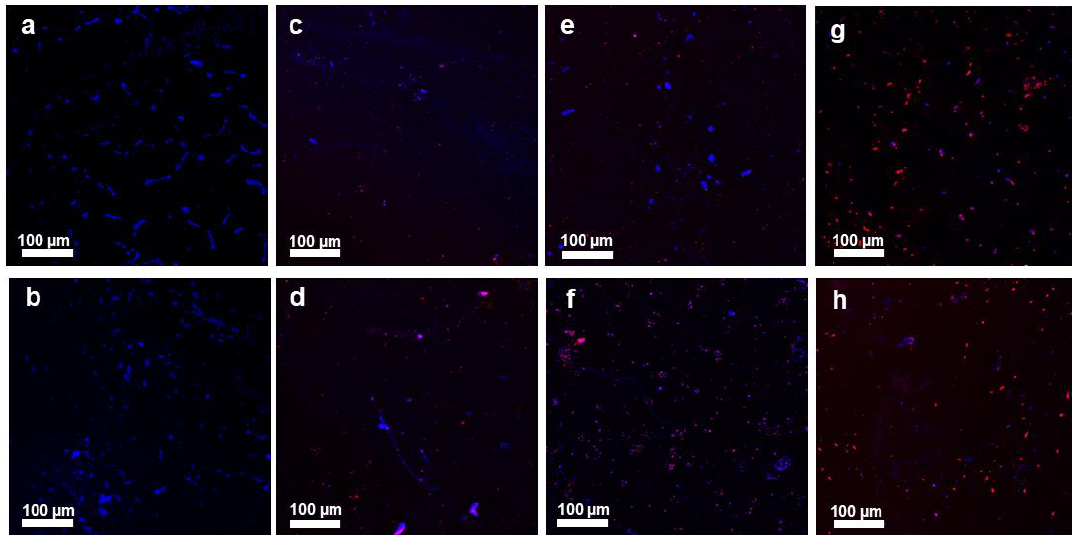
Figure 8. Confocal fluorescent images of control E. coli ( a ) and control S. Aureus ( b ), those exposed to GO ( c , d ), to Ag NPs ( e , f ), and to GO-Ag NPs ( g , h ), respectively. The fluorescent images are captured under CLSM after dying with HS and PI.